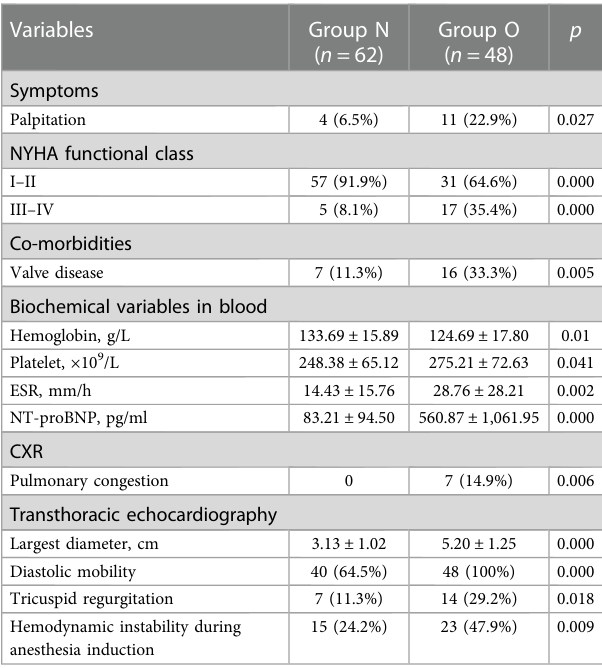
( Figure 3 ). As shown in Table 5 , the mean postoperative